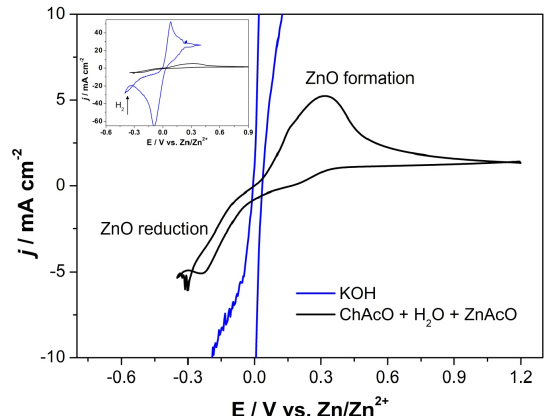
Figure 10. CV of a zinc foil in (black) 30 wt.% water-containing ChAcO + 0.01 M ZnAcO and (blue) 7 M KOH electrolyte at 10 mV s − 1 . Inlet: zoom out of Zn oxidation / ZnO reduction voltammogram in 7 M KOH.